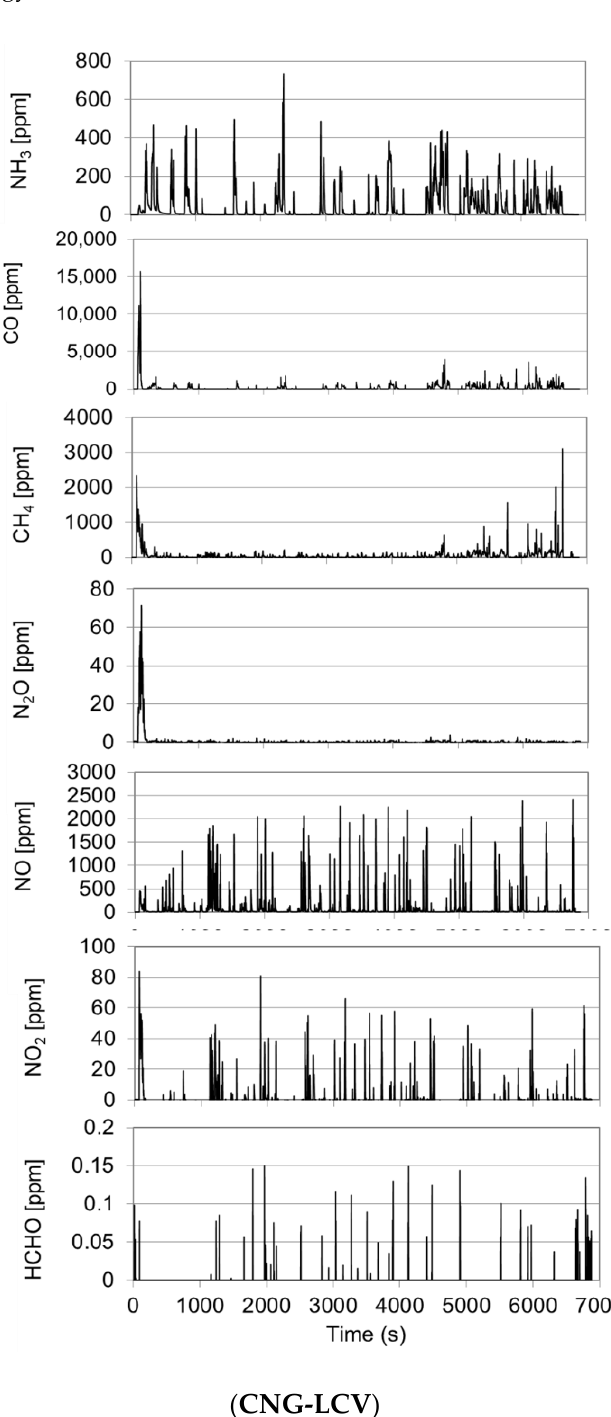
Figure 5. NH 3 , N 2 O, NO, NO 2 , CO, CH 4 , and HCHO on-road emissions profiles registered during the RDE test on Route-3 for the CNG-LCV.